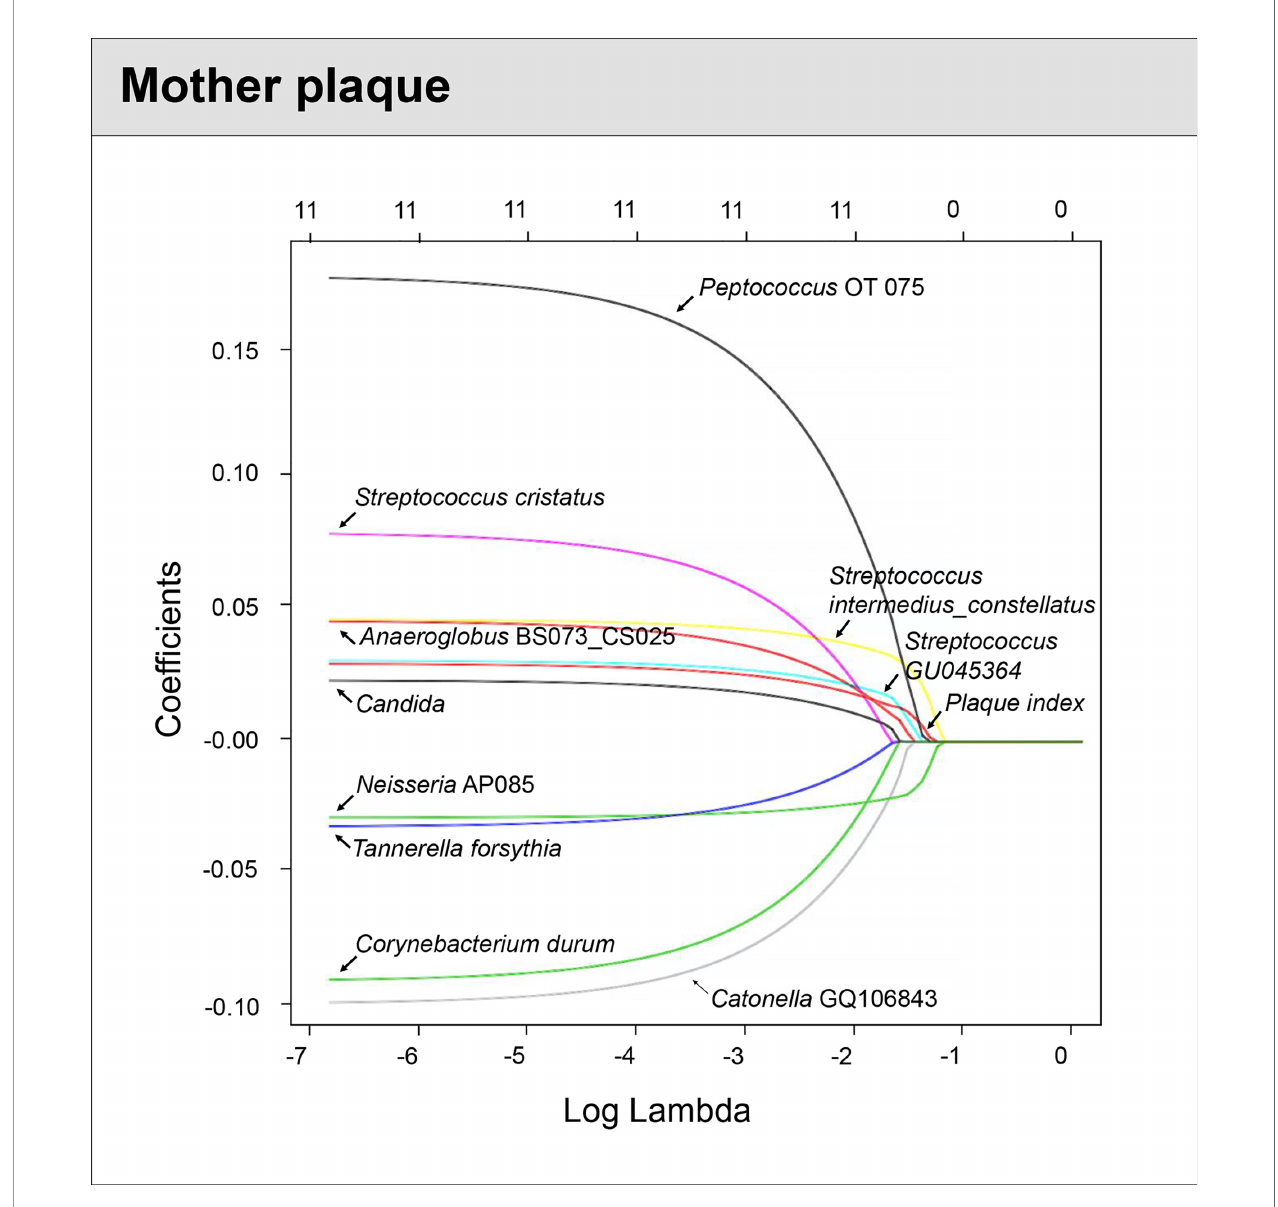
FIGURE 5 | Identi fi ed factors associated with mother ’ s caries risk using machine Learning model. LASSO-penalized logistic regression modeling was used for caries predictor selection for children ’ s saliva and plaque samples. Eleven variables for models using plaque microorganisms were identi fi ed as predictive factors for dental caries in mothers. The LASSO solution path above shows how the model is built sequentially by adding one variable at a time to the active